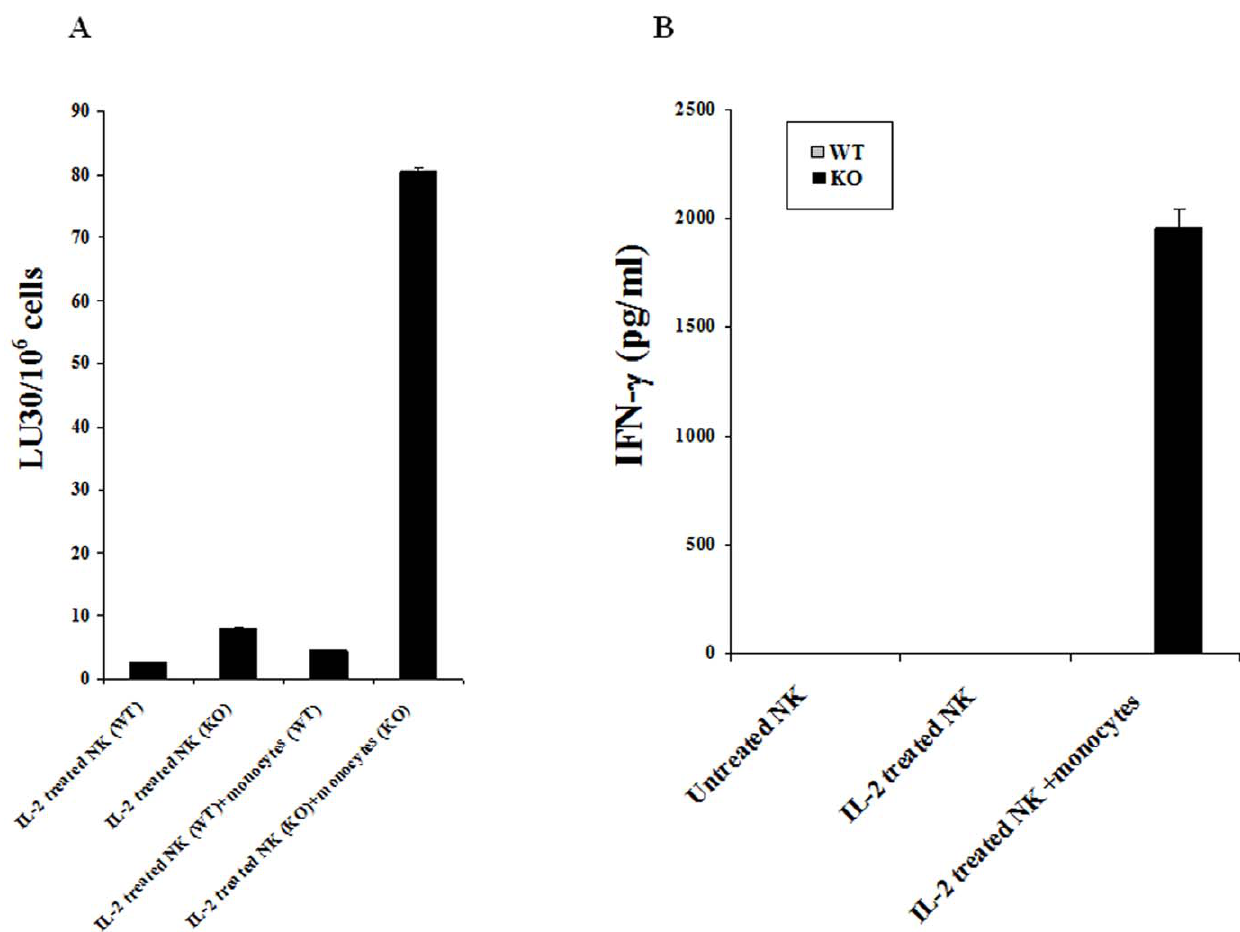
Figure 9. Targeted inhibition of COX2 in bone marrow monocytes increased NK cell cytotoxicity and secretion of IFN- c by IL-2 treated NK cells. Purified NK cells and monocytes were obtained from spleens and bone marrows of 3 pooled control mice and those with targeted knock down of COX2 gene in myeloid cells respectively (n=3). Purified NK cells and monocytes from control mice and those with targeted knock down of COX2 gene in myeloid cells were then cultured with IL-2 (1000u/ml) at 1:1 NK: monocyte ratios for 6 days before they were added to 51 Cr labeled YAC cells, and NK cell cytotoxicities were determined in 4 hour 51 Cr release assay. The lytic units 30/10 6 cells were determined using inverse number of NK cells required to lyse 30% of the YAC cells 6 100 ( A ). NK cells were cultured as described in Fig. 9A and after 6 days of incubation the supernatants were removed and IFN- c secretion were measured in the supernatants using a specific ELISA ( B ). One of five representative experiments is shown in this